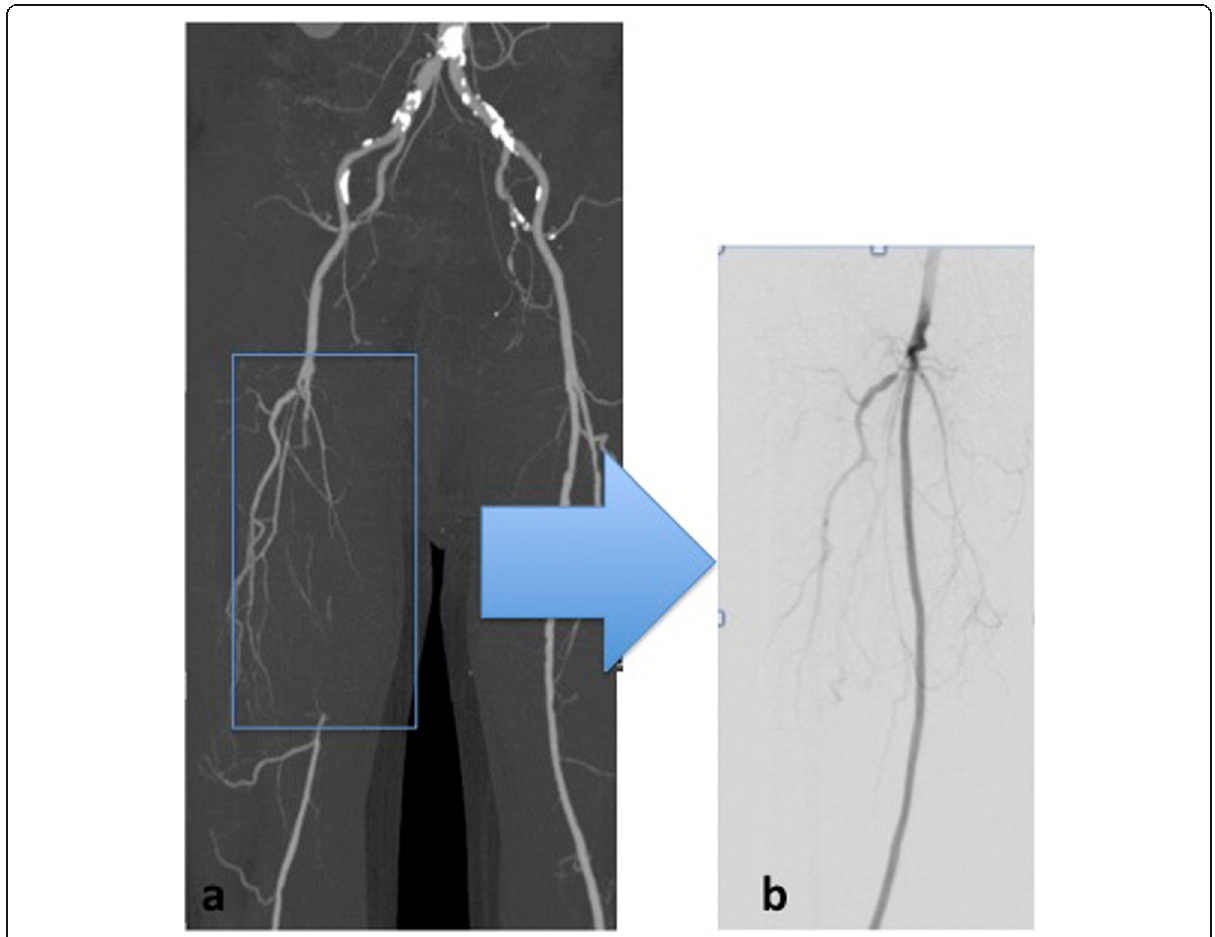
Fig. 1 Imaging of the superficial femoral artery occlusion lesion before and after endovascular therapy. a Preoperative computed tomography angiography revealing the superficial femoral artery occlusion lesion. b Post-stenting angiography revealing no